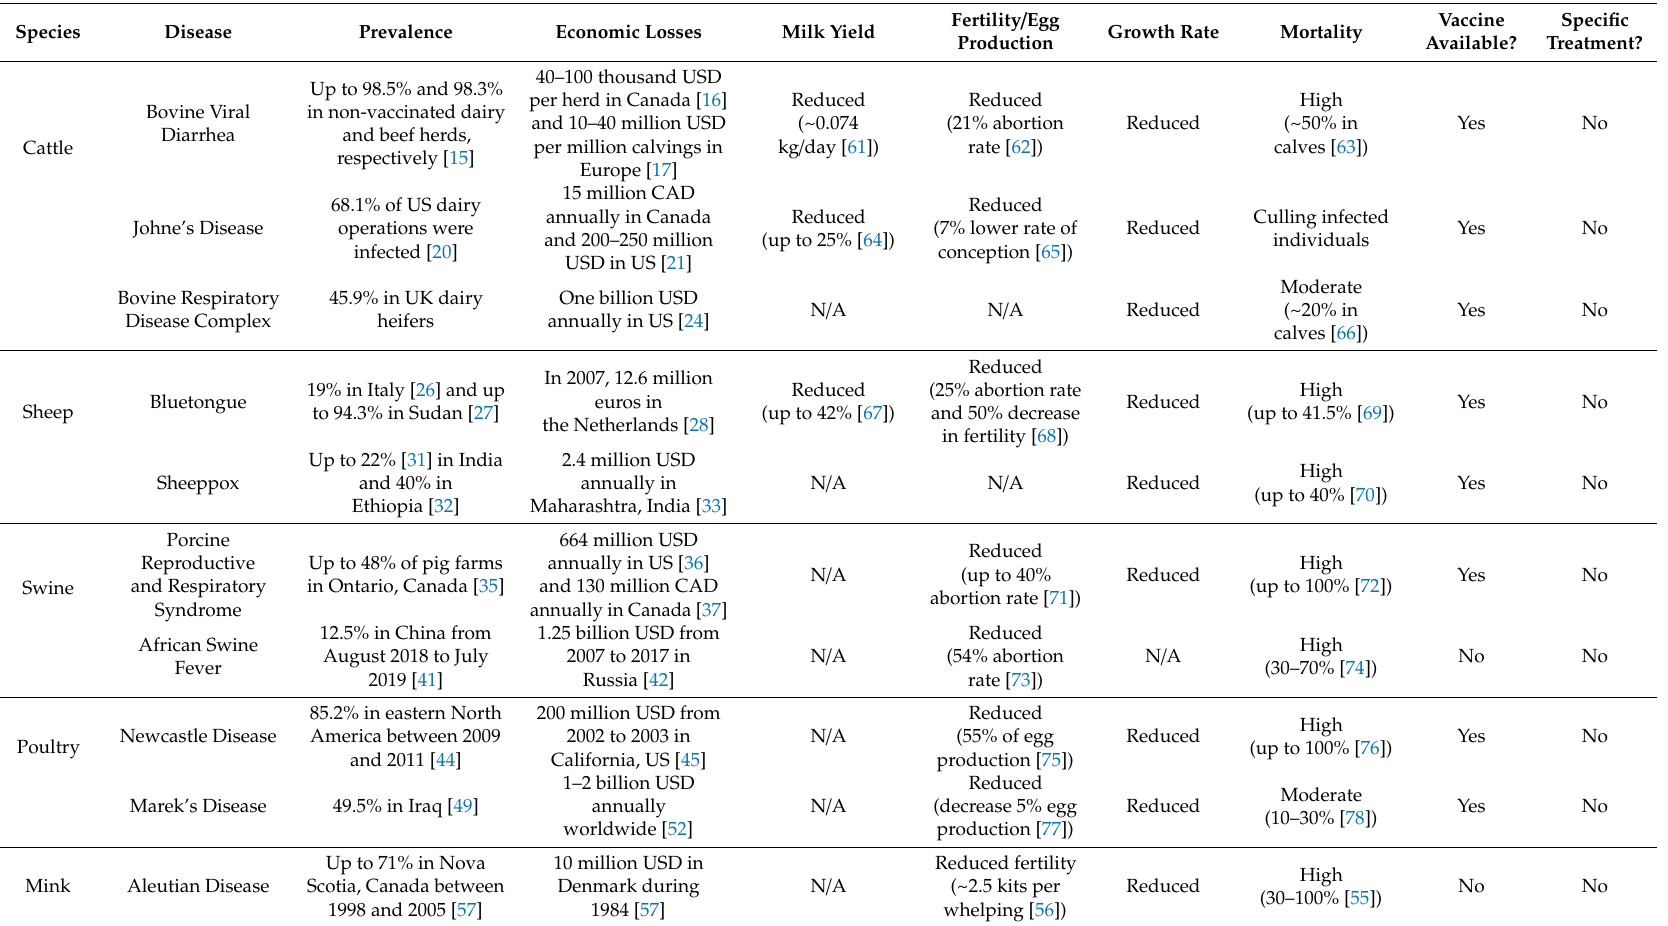
Table 1. Prevalence and economic losses of common diseases and their impacts on performance in farm animal